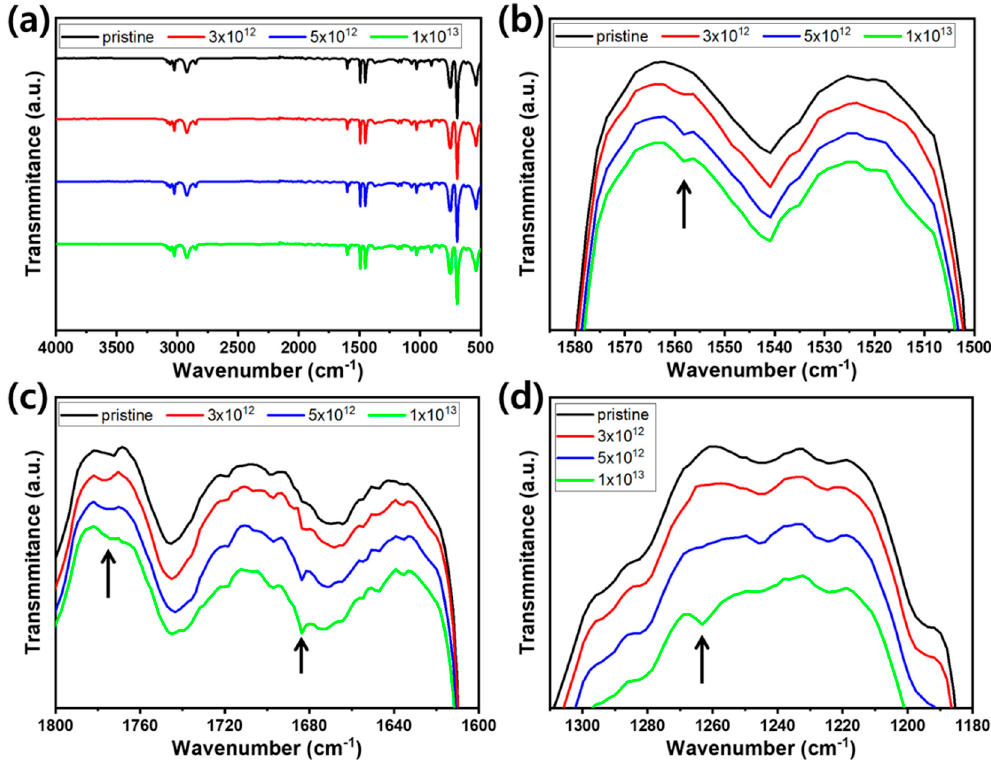
Figure 7. FT-IR spectra of pristine and irradiated PS in the ( a ) 4000–500 cm − 1 , ( b ) 1590–1500 cm − 1 , ( c ) 1800–1600 cm − 1 , and ( d ) 1320–1180 cm − 1 wavenumber